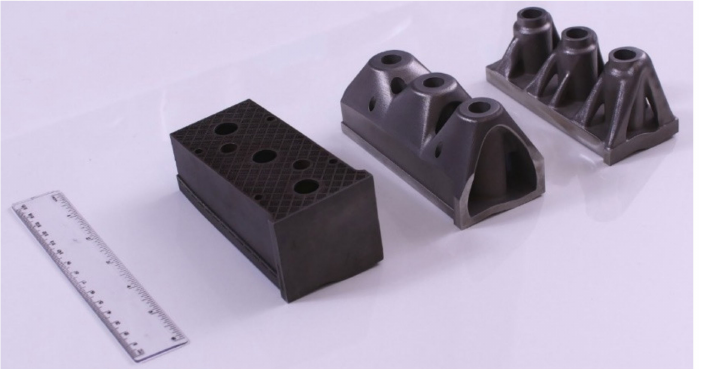
Figure 15. Three (3) versions of the industrial punch (Figure 13)—all 3D-printed (L-PBF) in DIN 1.2709: ( left ) with a honeycomb inner structure, ( middle ) after topology optimization using LS-TaSC and ( right ) after topology optimization using NX12 [62]. See also Figure